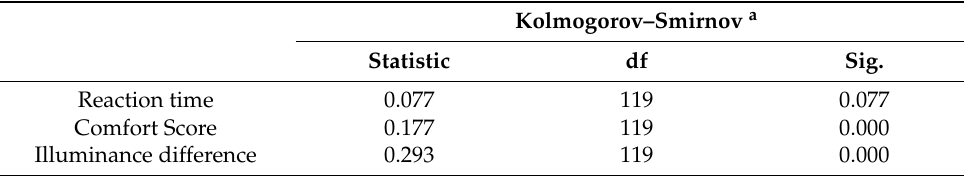
Table 4. Test for normality under increasing illuminance.